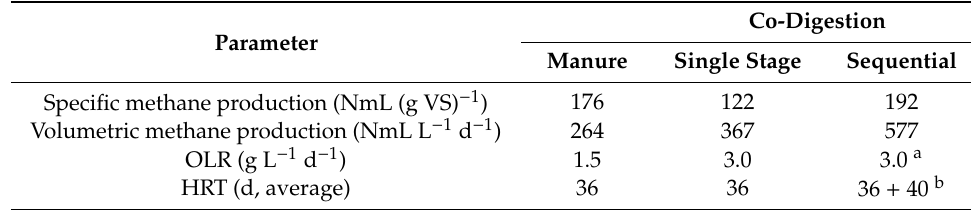
Table 3. Process performance parameters for the single-stage and sequential co-digestion experiments and the manure control. VS: volatile solids.